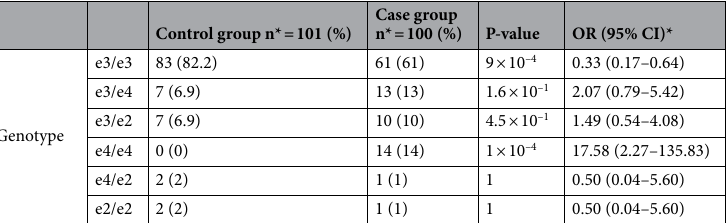
Table 1. Genotypes frequency of both control and case groups. *n: sample number, OR: odds ratio, and CI: confidence intervals.